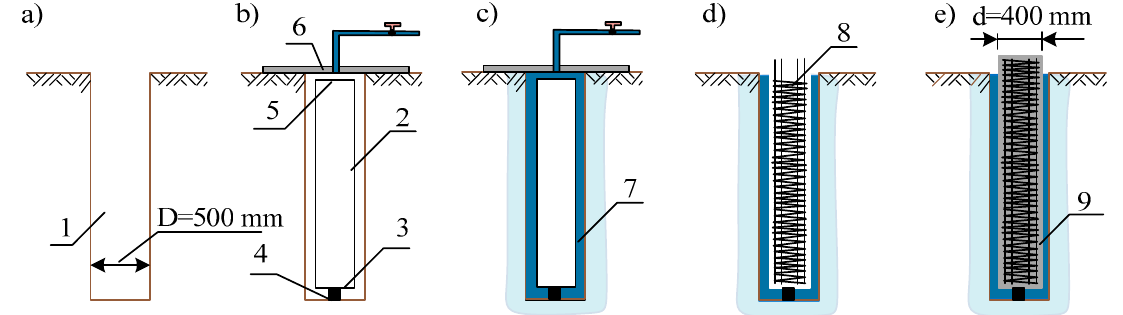
Figure 2. Installation of short-length bored piles in saline soils in a protective and load-bearing casted case: ( a ) borehole; ( b ) placement of the inner tube in the borehole; ( c ) impregnation of walls and bottom side with silicate solution; ( d ) rein- forcement; ( e ) concreting. 1—borehole; 2—steel tube with bottom flange; 3,4—position fixing; 5—top flange; 6—disk seal with solution supply pipeline; 7—protective shell; 8—reinforcement; 9—concrete.